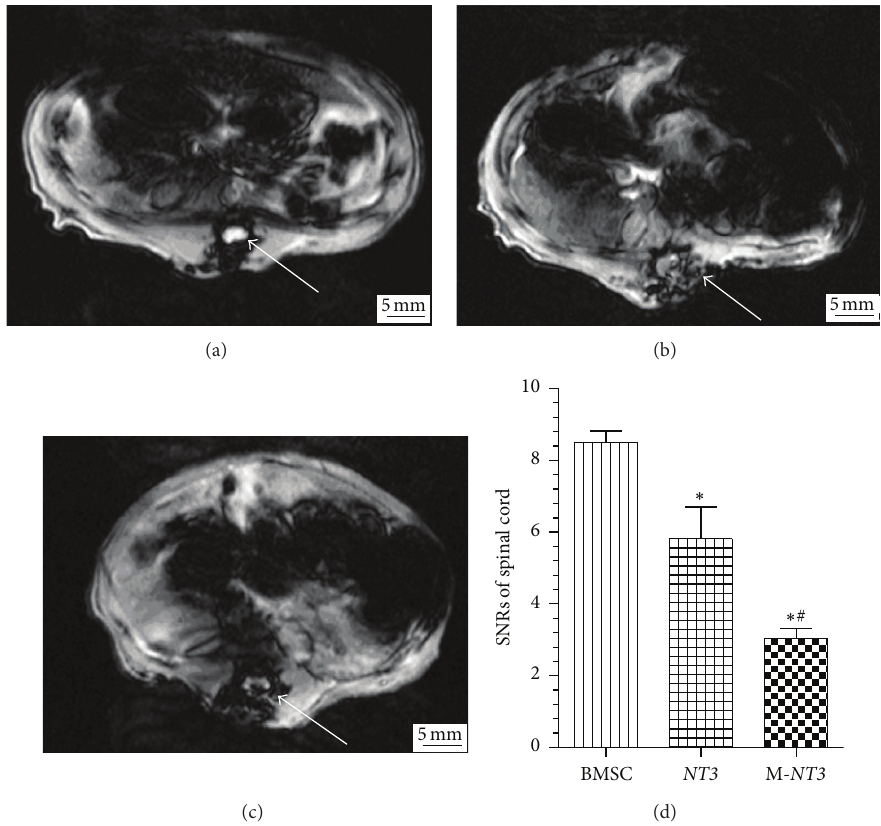
Figure 3: T 2 ∗ -weighted MR images of the injured spinal cord on day 1 after cell transplantation in the BMSC group (a), NT3 group (b), and M- NT3 group (c). A bar graph showing the SNRs in the injured spinal cord MR images from each group (d). The data, which are presented as the means ± SD ( 𝑛 = 12 ), were analyzed using one-way ANOVA. ∗ 𝑝 < 0.05 versus the BMSC group, # 𝑝 < 0.05 versus the NT3